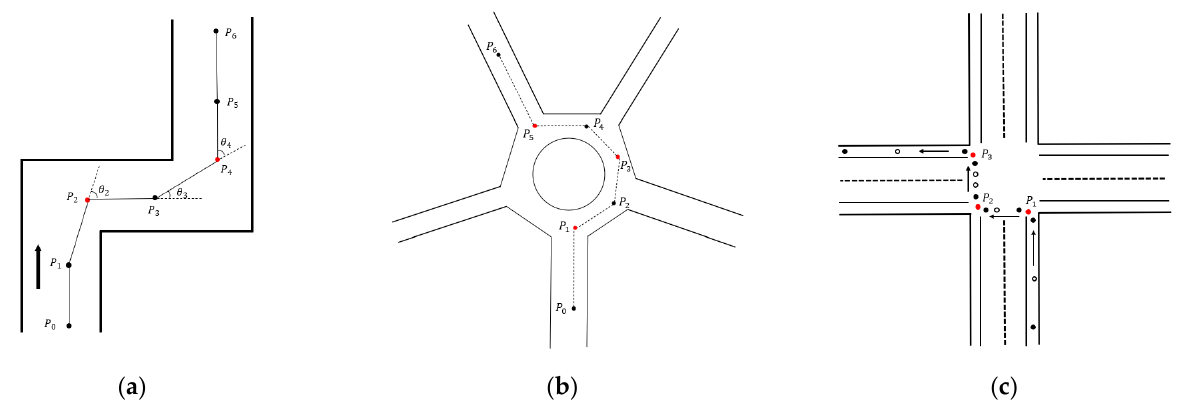
Figure 8. Diagram of complex turning mode: ( a ) complex turning mode in narrow road; ( b ) complex turning mode in circular road; ( c ) complex turning mode at large road intersection.